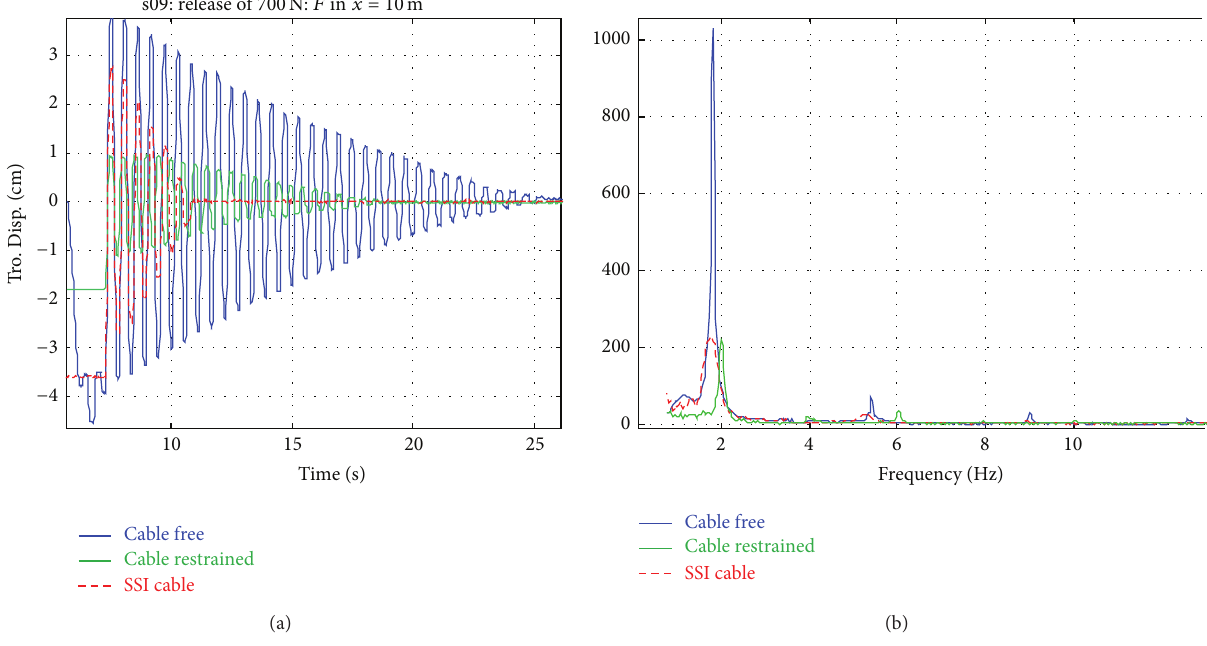
Figure 7: (a) Displacement and (b) associated spectrum at 22.5 (midspan) on the free, constraint, and SSI cable no. 1.